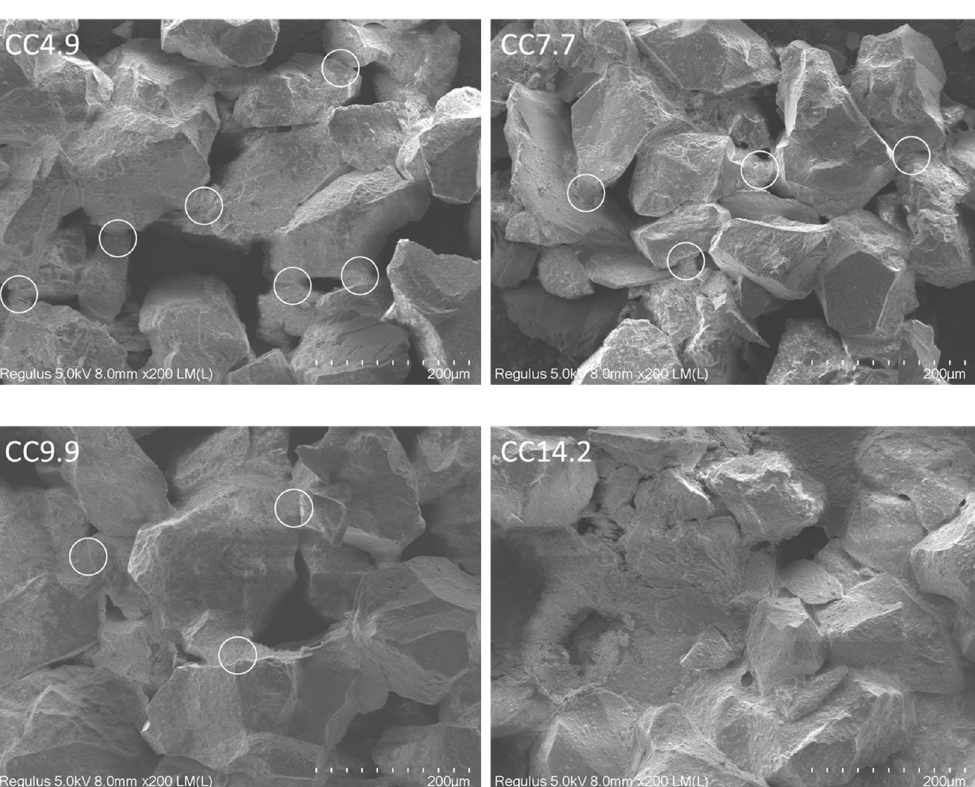
Figure 9. The microfabric of seabed with different CC (aggregation in white circle).